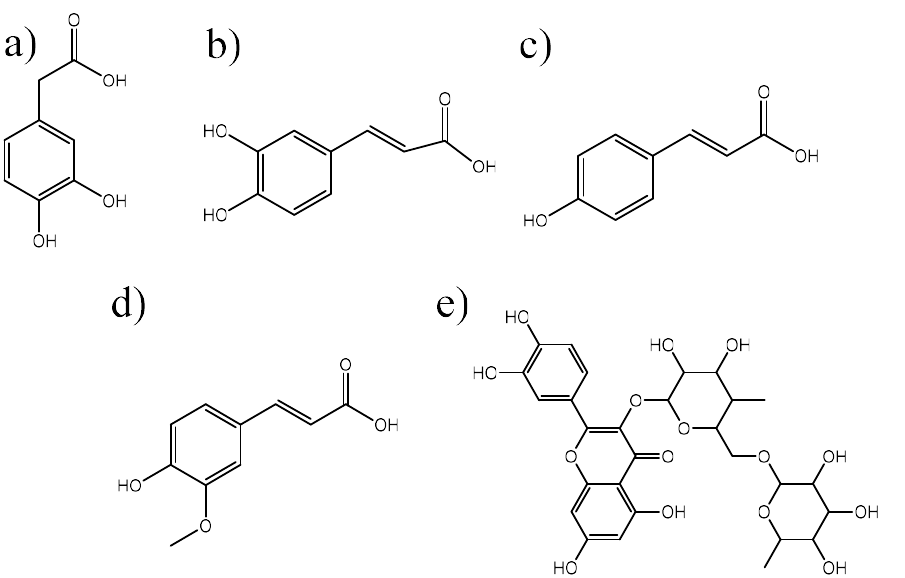
Figure 1. Chemical structures of the natural polyphenols tested. ( a ) 3,4-Dihydroxyphenylacetic acid (DOPAC); ( b ) caffeic acid; ( c ) p -coumaric acid; ( d ) ferulic acid; ( e ) rutin.